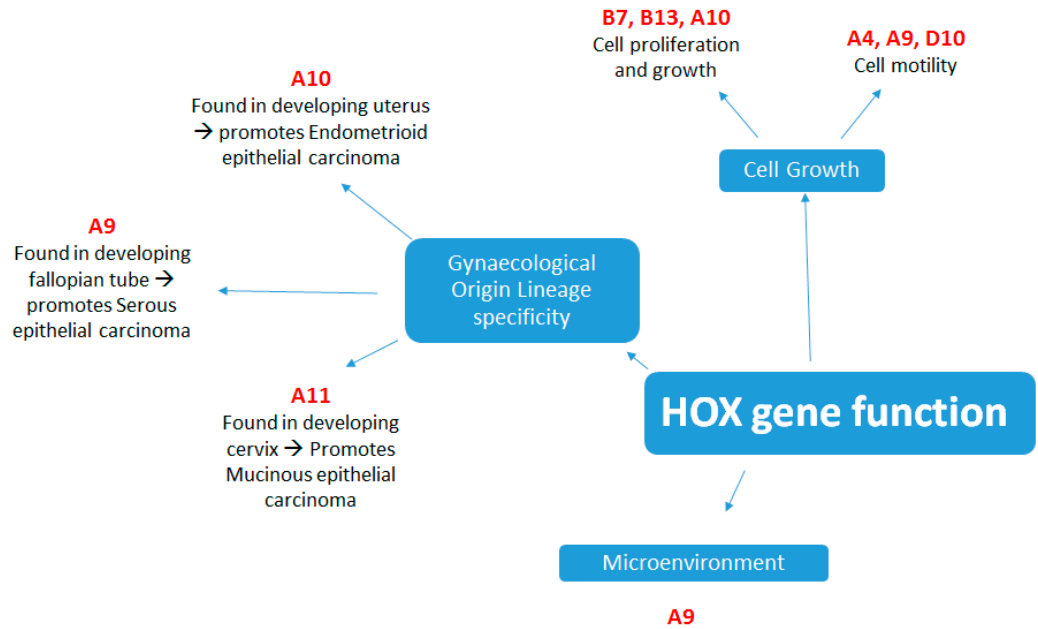
Figure 1. The main functions of HOX genes in the oncogenesis of ovarian carcinoma. Table 1. HOX gene expression. Table 1 shows the 39 HOX genes and indicates which are commonly over or under expressed in ovarian cancer cell lines or tissues relative to normal ovarian surface epithelium. Grey boxes are HOX genes that do not exist. ( ↑ = overexpressed, ↓ = underexpressed).